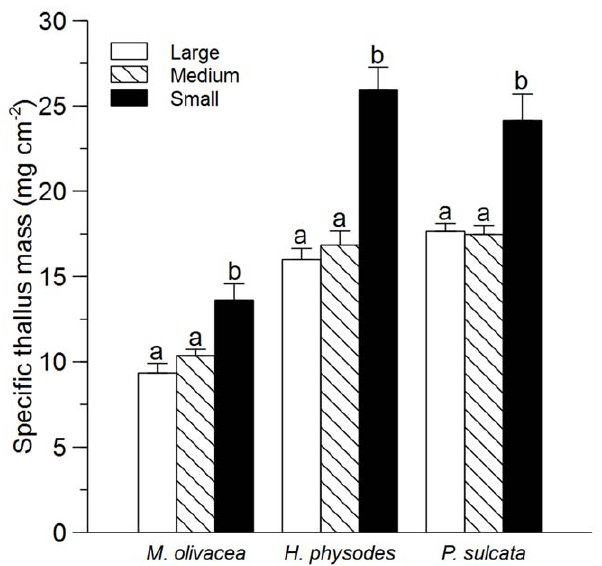
Figure 1. Response of lichen specific thallus mass to island size. Values are given for mean + SE of M. olivacea , H. physodes and P. sulcata on large small, medium and small sized islands. Letters on top of bars denotes significant differences (p , 0.001, Tukey’s post hoc test) within